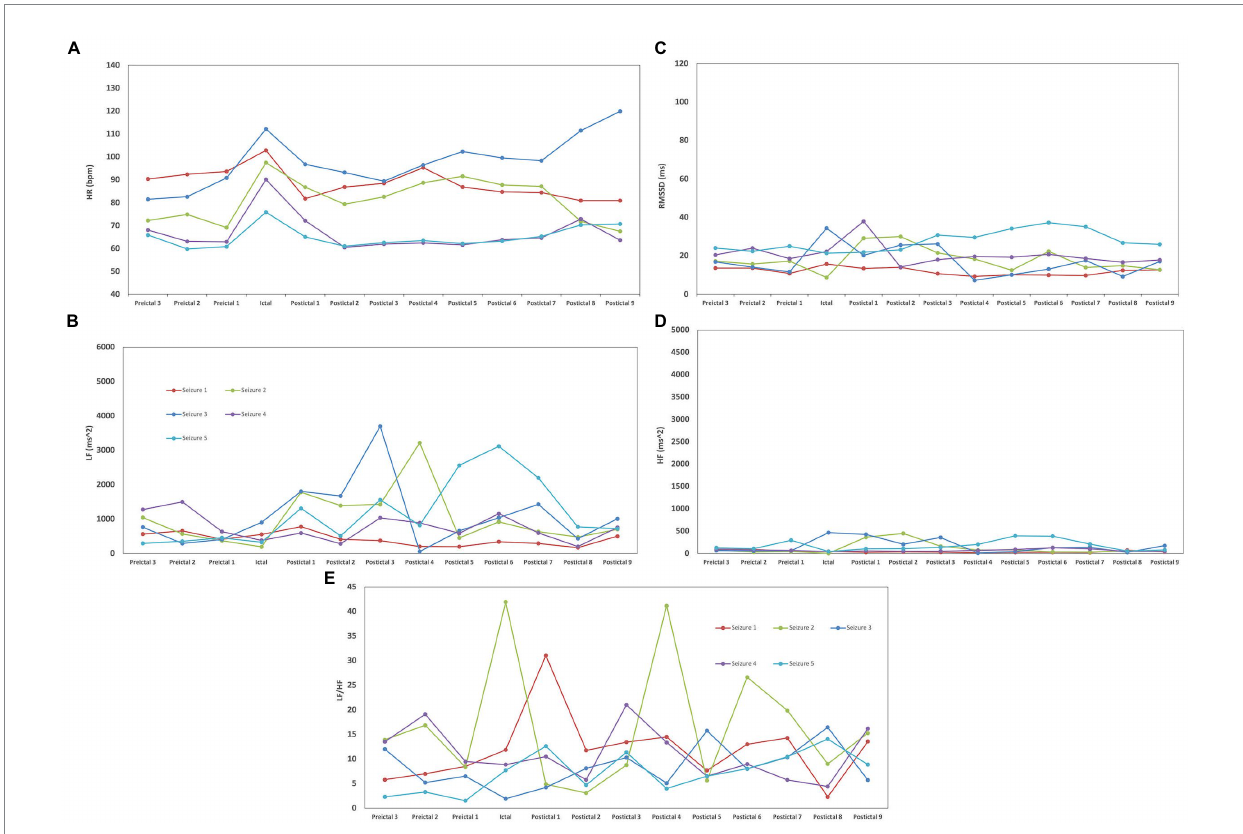
FIGURE 1 Heart rate variability (HRV) changes during preictal, ictal, and postical periods of five focal with impaired awareness seizures (FIAS) for the sudden unexpected death in epilepsy (SUDEP) patient. (A) For all seizures of both groups, we observed the same pattern of an increase in HR during the seizure and a decrease in postical HR when compared to the preictal state. In seizures 2 and 3, postictal mean HR was increased when compared to preictal mean HR (19.05–20.17%). (B) Delayed LF postical recuperation was seen, particulary in the nocturnal seizure of the SUDEP patient. In all seizures of the SUDEP patient, LF continued to increase in the first postictal period (39.8–819%) when compared to ictal LF. (C) In the SUDEP patient, a 21.97% increase in ictal RMSSD was seen when compared to preictal median RMSSD. Preictal RMSSD were 59.92–75.24% lower than those of the controls, with a statistically significant difference being noted in preictal RMSSD values between the two groups ( p < 0.05). (D) HF values were 92.45–97.18% lower than those of the controls. (E) LF/HF ratio was increased in all epochs in the SUDEP case when compared to controls; there was a significant difference in the postictal LF/HF ratio between the SUDEP patient and controls ( p < 0.05). In seizure 1 of the SUDEP patient, a pattern of important increase (161.24%) and decrease (62.05%) was seen between the ictal period and second postictal period. In seizure 2 of the SUDEP patient, a similar pattern was observed, with LF/HF ratio being increased by 401.40% during the seizure before decreasing by 88.31% during the 1 st postictal epoch. A similar increase in LF/HF (368.33%) and decrease (86.33%) was seen between the third and fifth postictal periods. No similar variations were noted in the other three seizures of the SUDEP